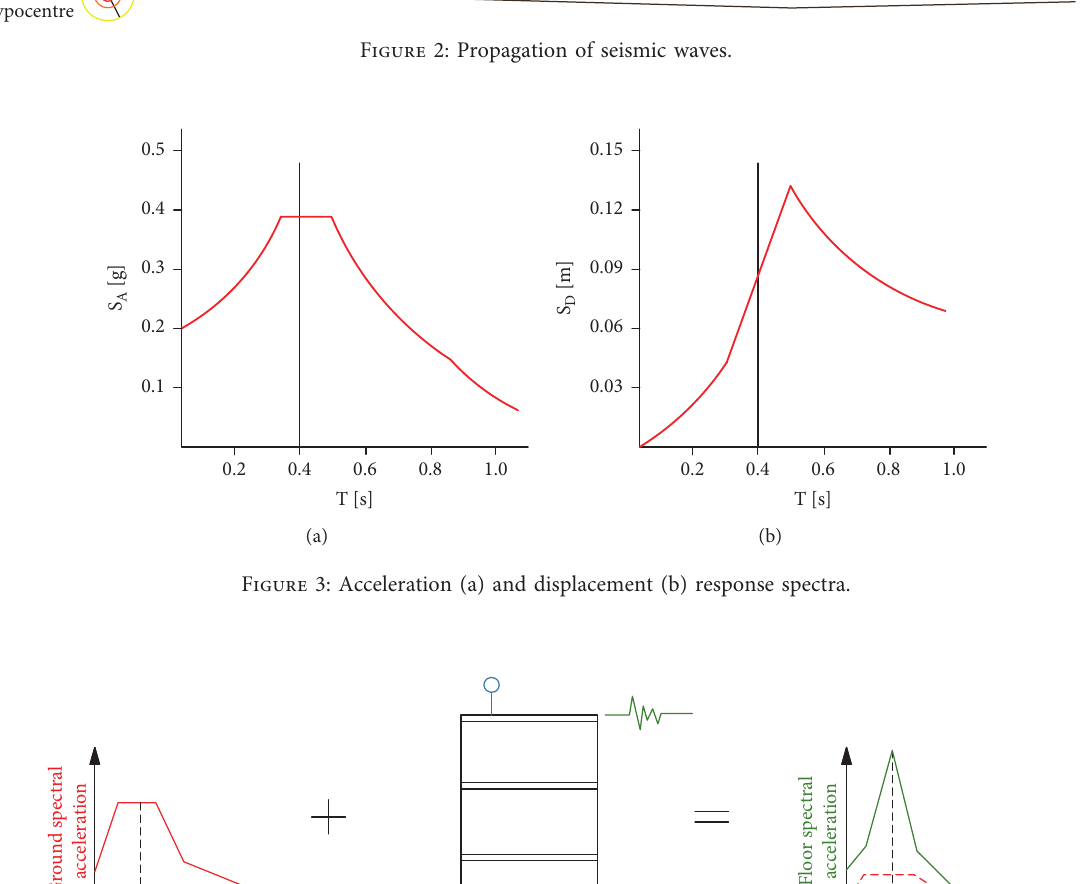
Figure 2: Propagation of seismic waves.